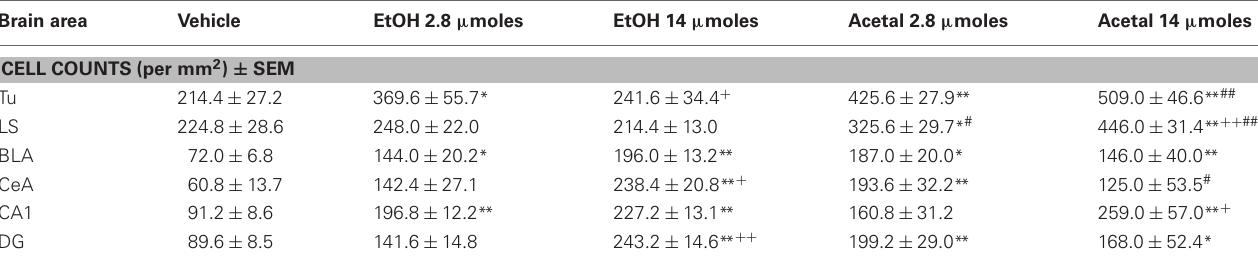
Table 6 | Effect of acute ICV administration of EtOH or acetaldehyde on c-Fos expression in limbic areas of rat brain. Brain area